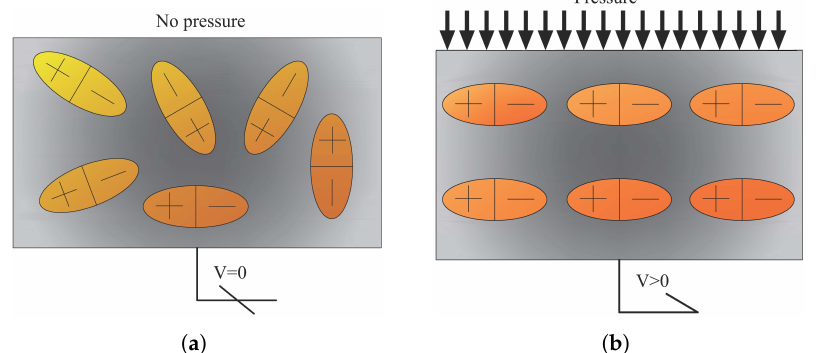
Figure 7. Piezoelectrics materials change their physical shape in response to an electric charge and vice versa; ( a ) before applying the loads (output voltage = 0); ( b ) after applying the loads (output voltage >